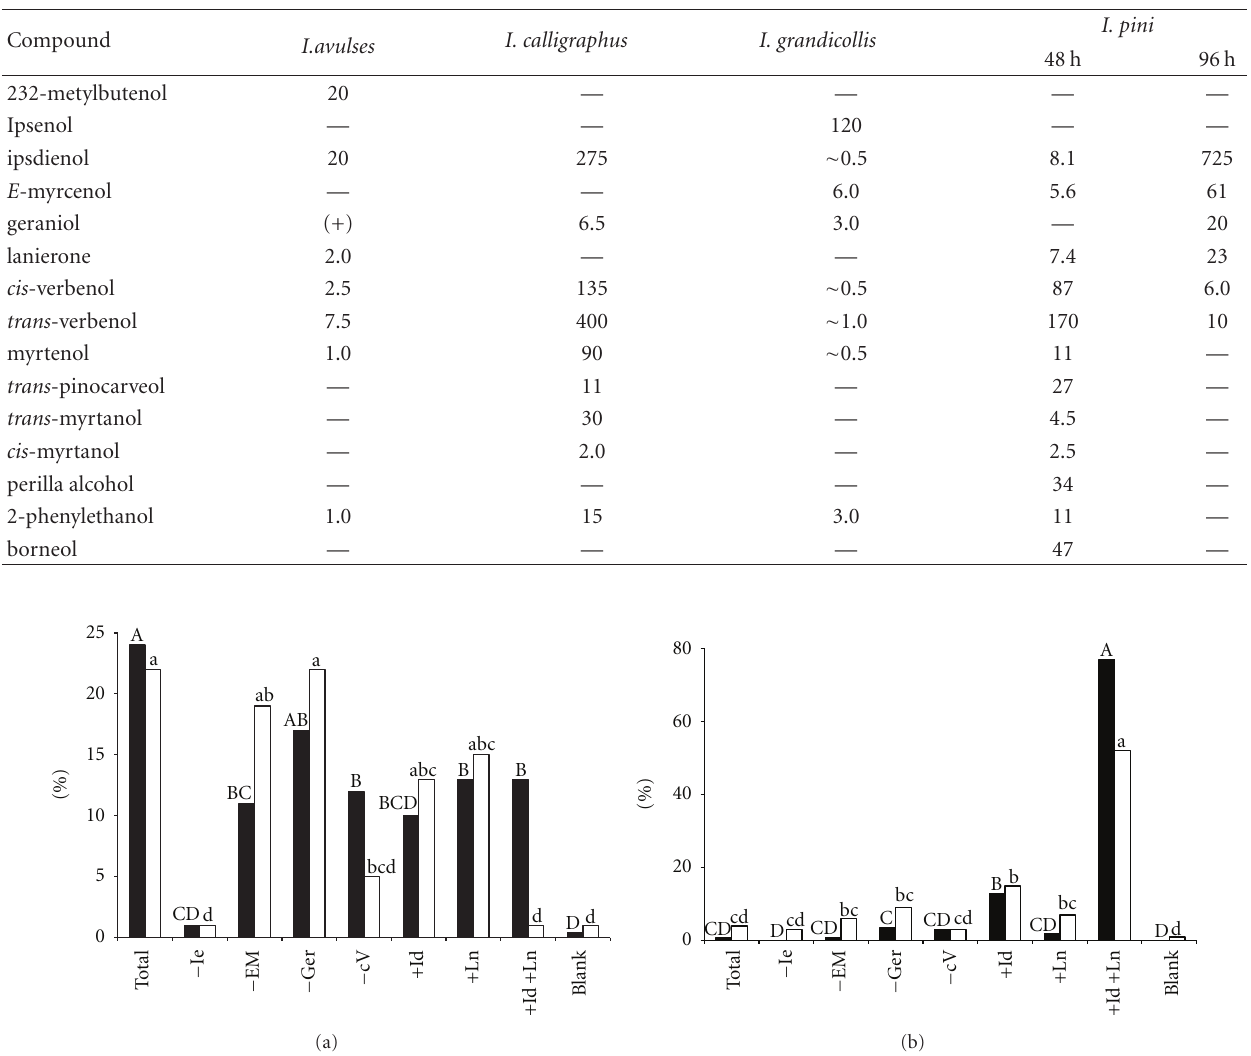
Table 4: Average amounts of volatiles identified in hindgut extracts: ng/unmated male.